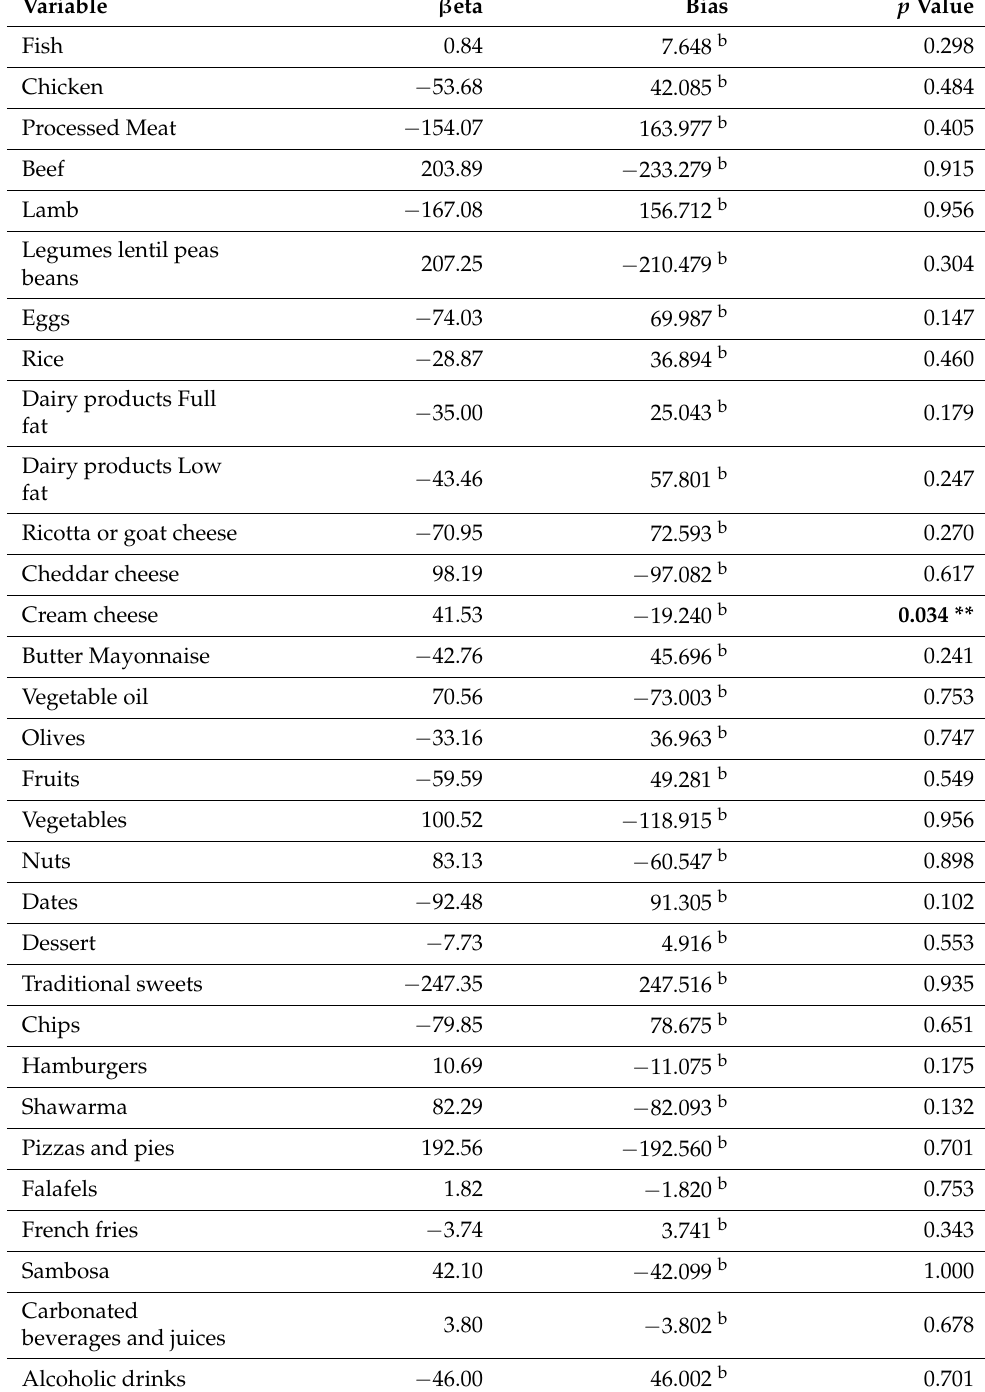
Table 3. Multivariate regression shows the association between risk of fatty liver and specific foods intake (fatty liver as dependent variable categorized in 3 levels = 0 no fatty liver; 1 not defined; 2 = yes fatty